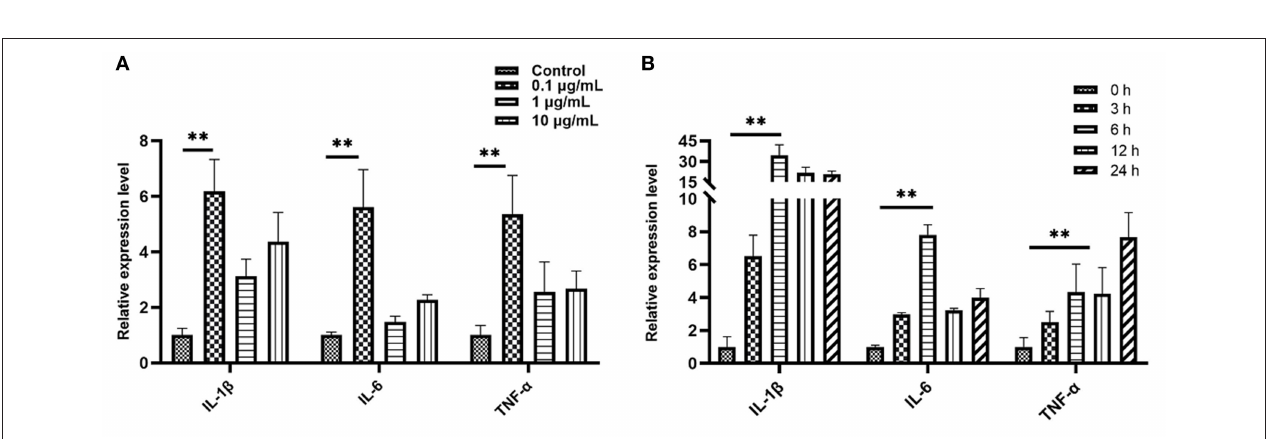
FIGURE 3 | Quantitative PCR analysis for the expression of pro-inflammatory cytokines such as IL-1 β , IL-6, and TNF- α . (A) Screening stimulation optimum concentration of LPS (stimulation for 6h). (B) Screening stimulation optimum timing with 0.1 µ g/mL. Values are mean ± SD ( n = 4). Significance is indicated by ** P <